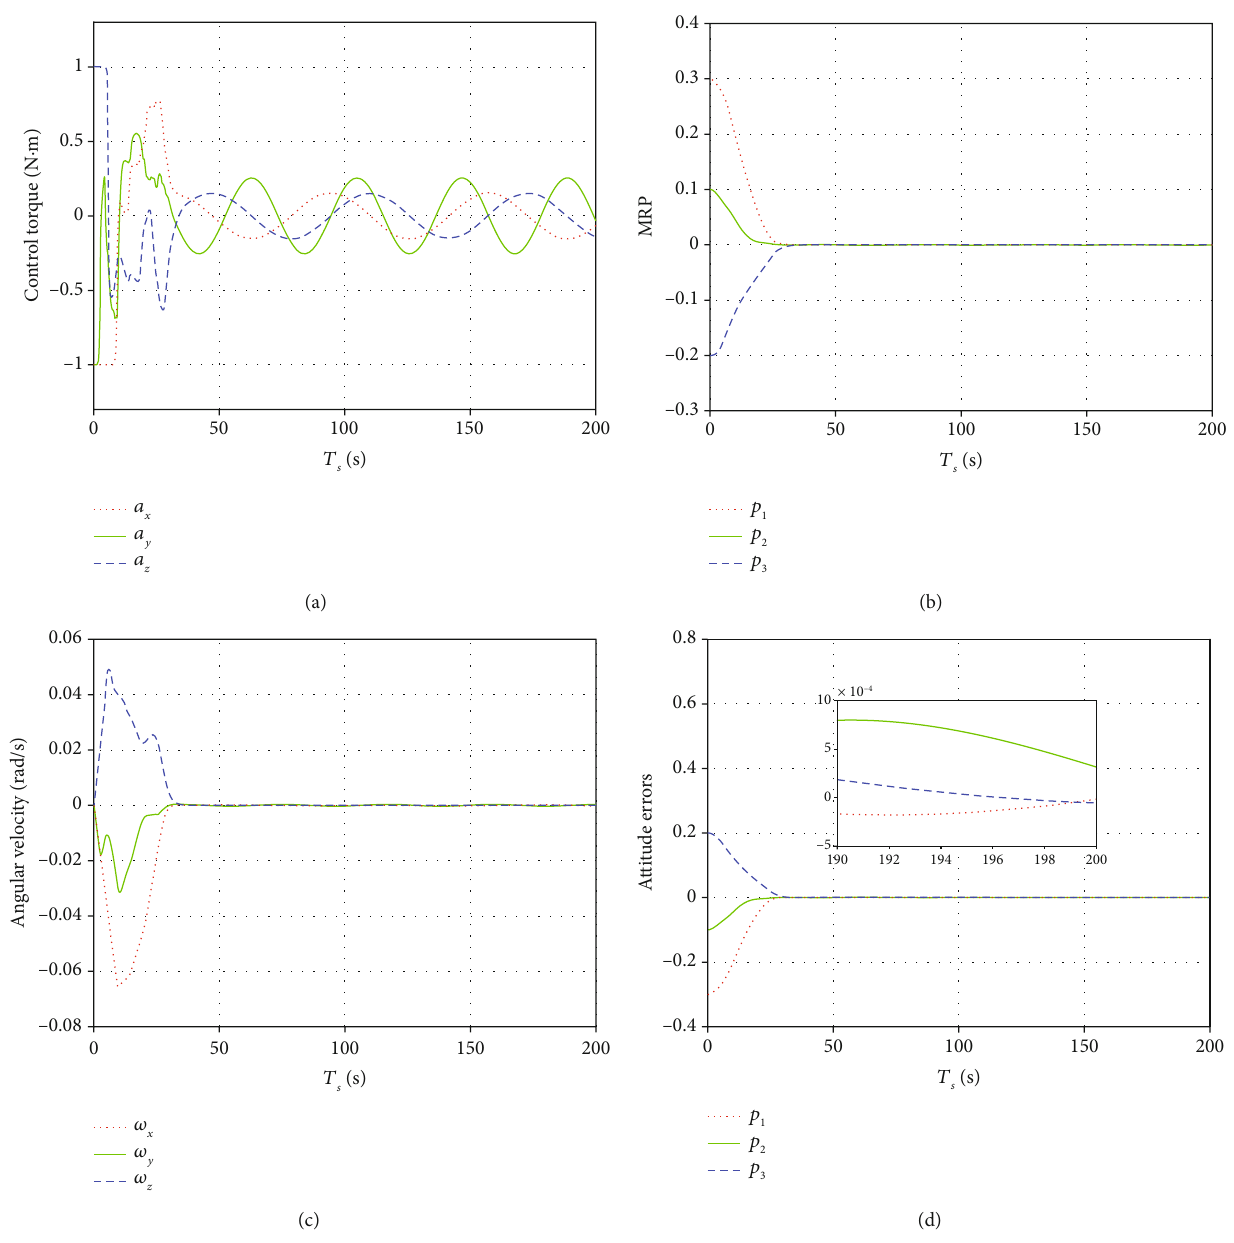
Figure 8. Compared with the ideal environment, the training